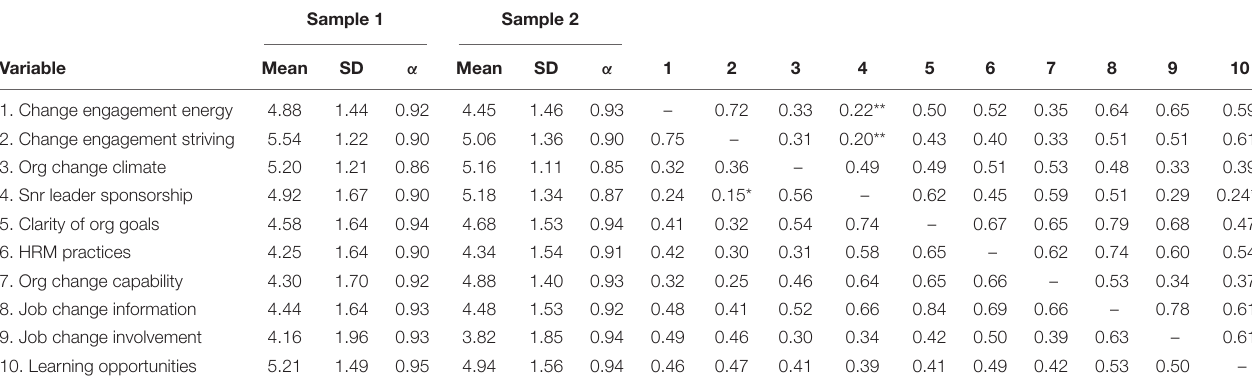
TABLE 2 | Means, standard deviations (SD), Cronbach’s alpha ( α ), and correlations among first-order variables in the respecified measurement models Sample 1 ( N = 225; below diagonal) and Sample 2 ( N = 201; above diagonal). Sample